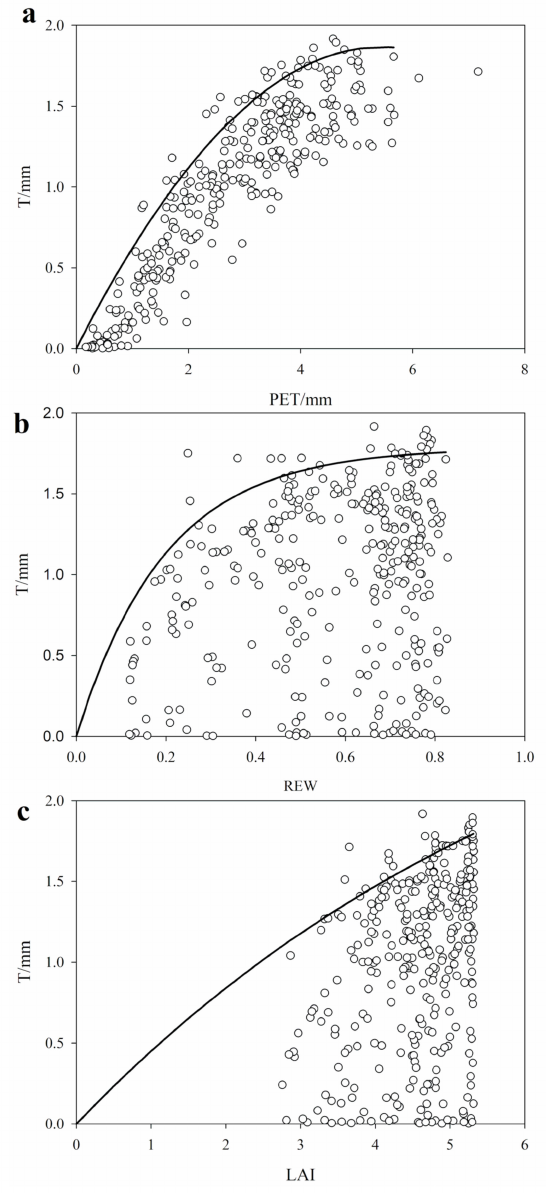
Figure 5. Responses of the daily transpiration (T) to the PET ( a ), the relative extractable soil water content (REW) ( b ), and LAI ( c ). The upper boundary line (solid black line) represents the T response to a single influencing factor, and it shows the T response in a parabolic way to PET ( a ), whereas in a saturated exponential way to both REW ( b ) and LAI ( c ). The data points (hollow circle) represent the measured data of given variables (PET, REW, LAI) corresponding to